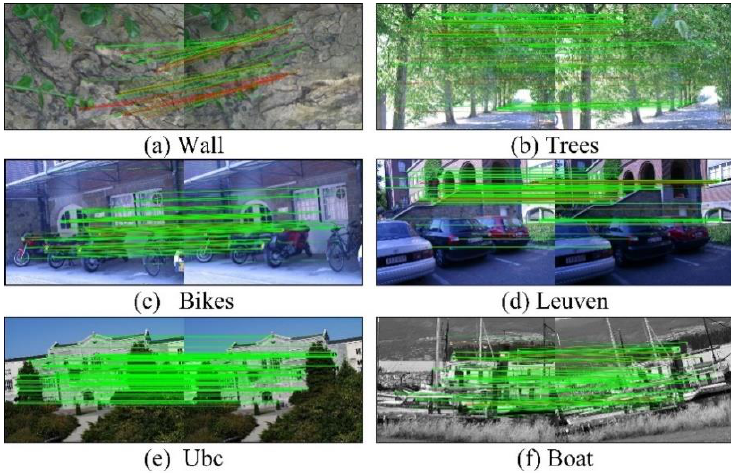
Figure 8. Matching effect of images from Oxford dataset using our method. ( a ) Wall (viewpoint), ( b ) trees (blur), ( c ) bikes (blur), ( d ) Leuven (illumination), ( e ) Ubc (JPG compression), ( f ) boat (rotation and scale).